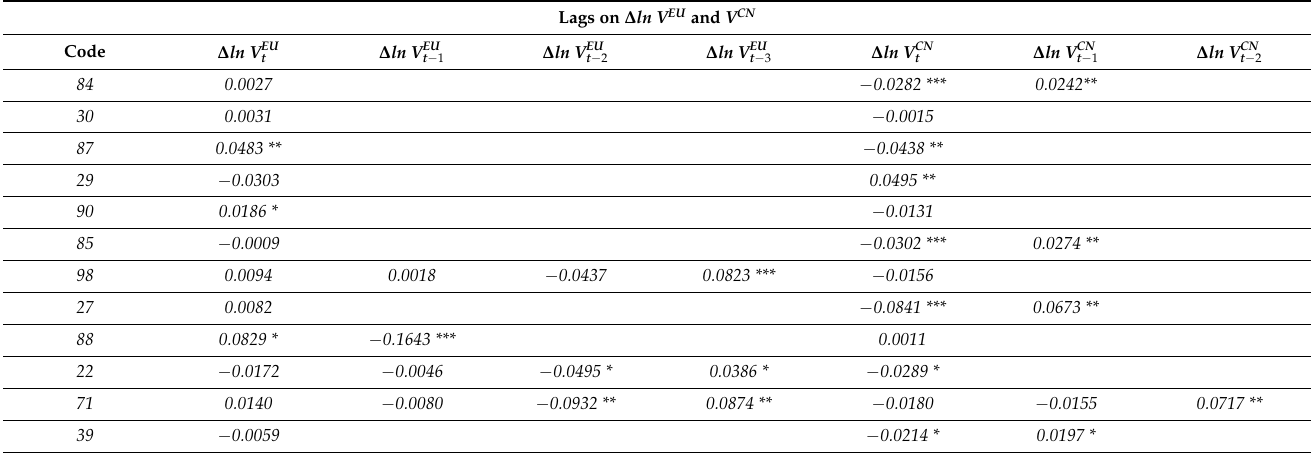
Table 5. Short-run coefficient estimates of volatility effects on US imports from the EU with third country effects using the linear ARDL model